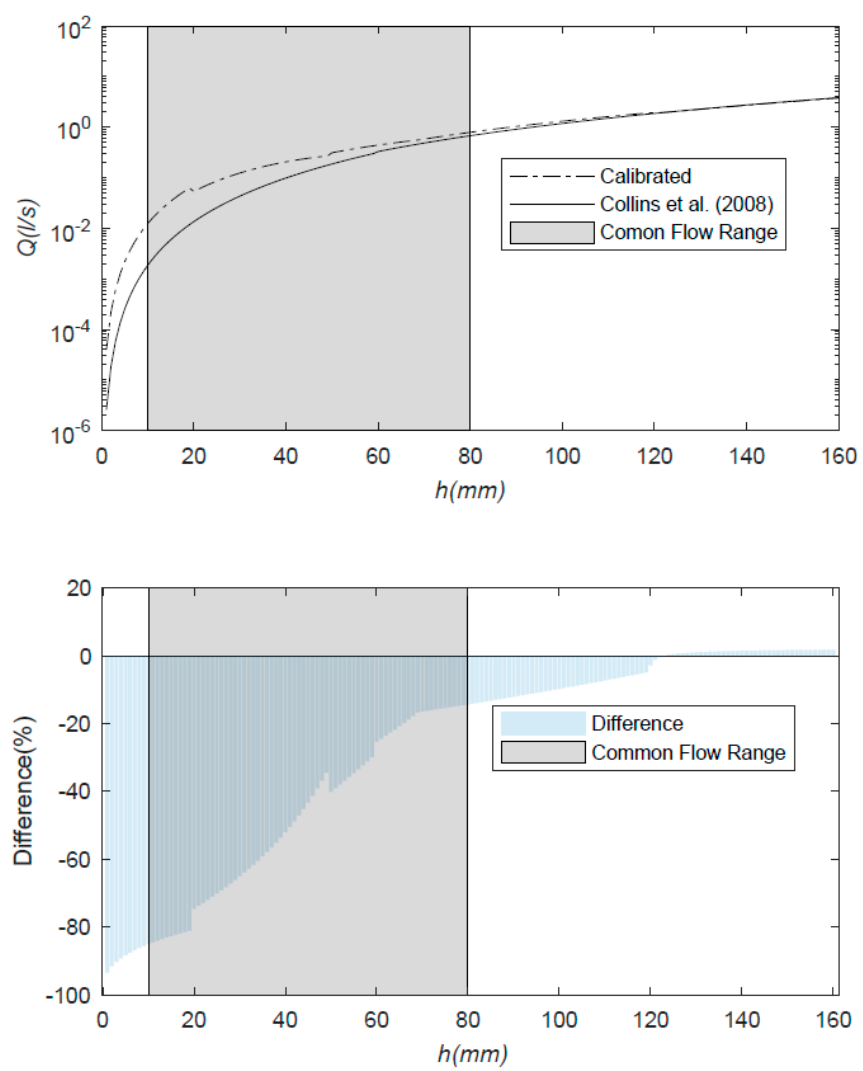
Figure 10. Comparison of flow (in logarithmic scale) versus head, computed using Collins et al.’s [12] rating curve and Equation (3) from this study.